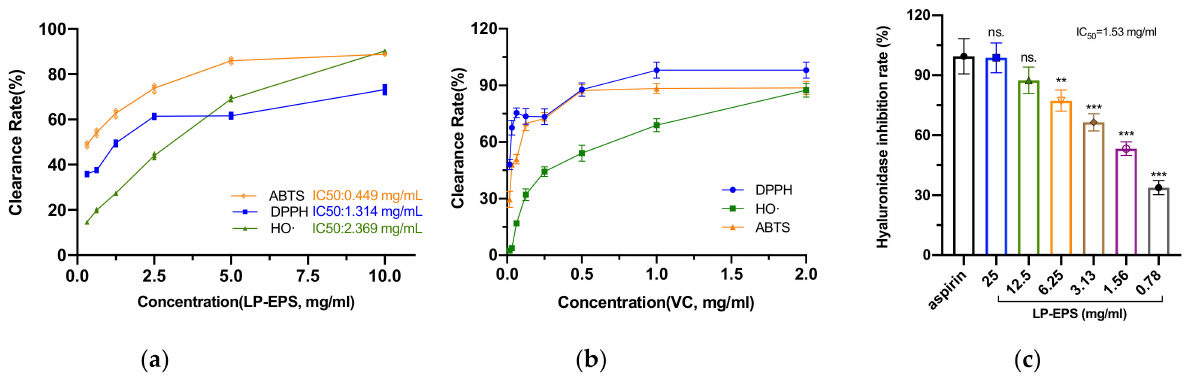
Figure 3. In vitro biochemical experiments: ( a ) in vitro antioxidant assay of LP-EPS; ( b ) in vitro antioxidant assay of VC; ( c ) hyaluronidase inhibition assay. ns.: p > 0.05, **: p < 0.01, ***: p <